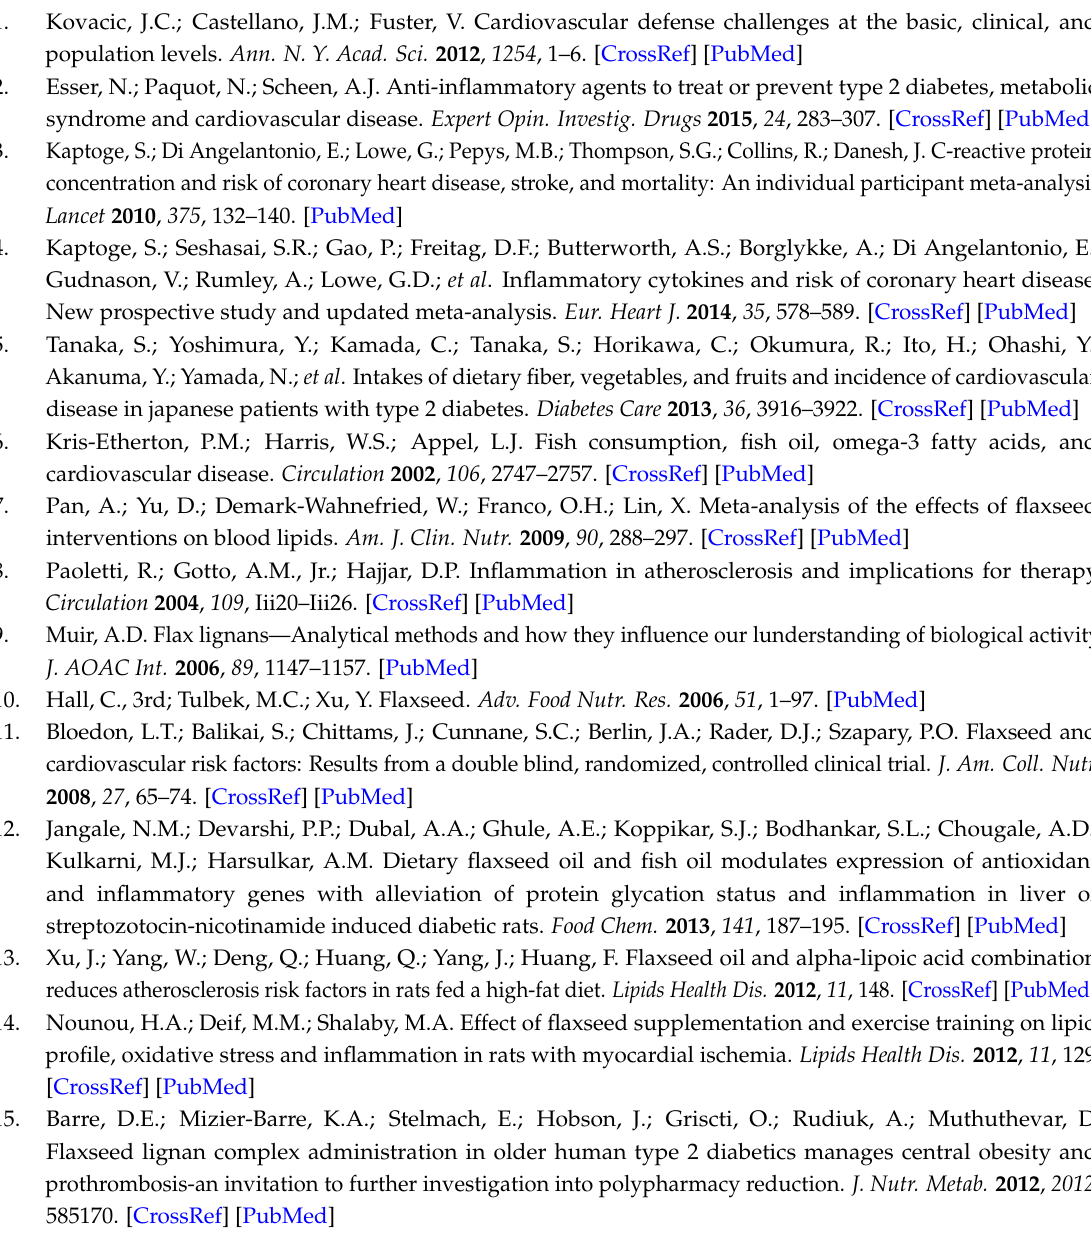
Table S1: Literature search strategy for meta-analysis, Table S2: Characteristics of excluded studies and reasons for